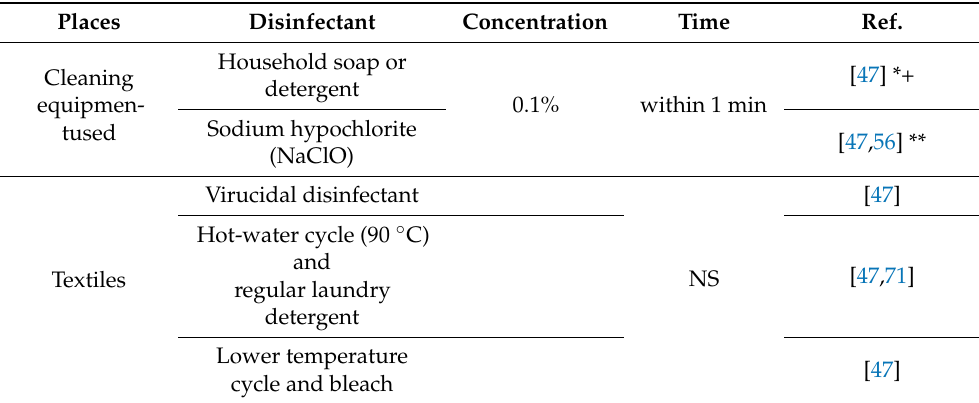
Table 2. Cont. Places Disinfectant Concentration